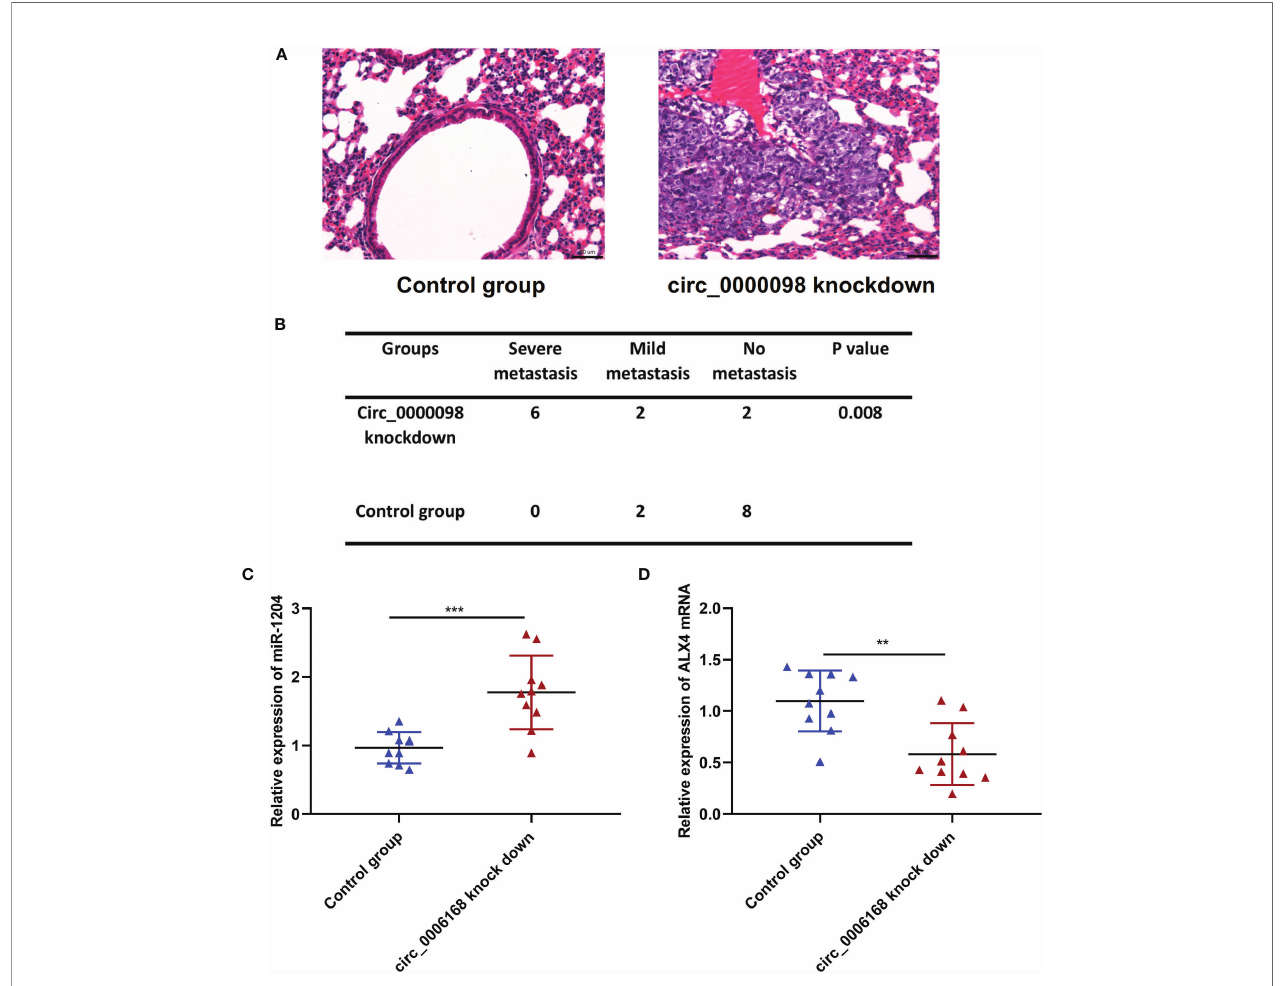
FIGURE 6 | Circ_0000098 knockdown promotes the lung metastasis of Huh7 cells in vivo . (A) H&E staining was used to detect the metastatic nodule of the mice, which were injected with Hu7 cells with circ_0000098 knockdown or the control cells, and the representative images were shown. (B) The statistical analysis of the lung metastasis of the nude mice in the control group and circ_0000098 knockdown group. (C, D) qRT-PCR was used to detect the expression of miR-1204 and ALX4 mRNA in the lung tissues of the circ_0000098 knockdown group and the control group. ** P < 0.01 and *** P <